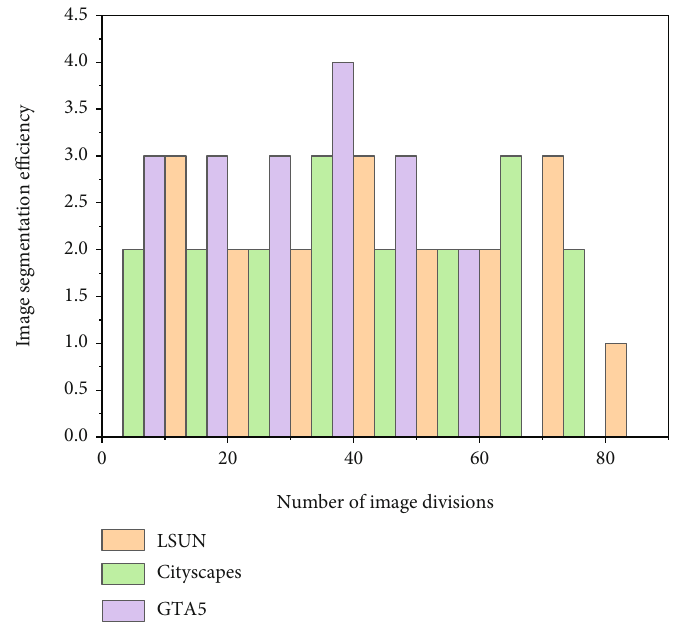
Figure 5: Comparison of the e ffi ciency of image segmentation techniques.